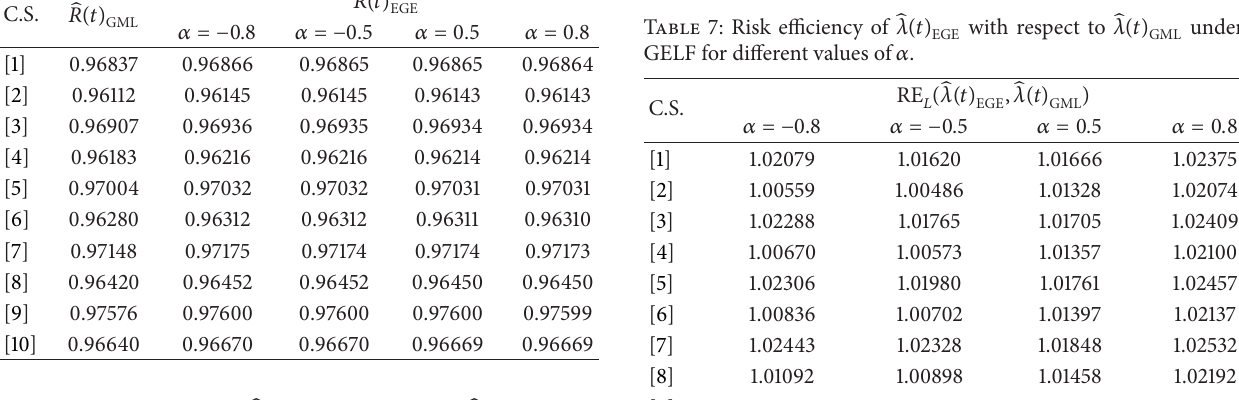
̂𝑅(𝑡) with respect to EGE